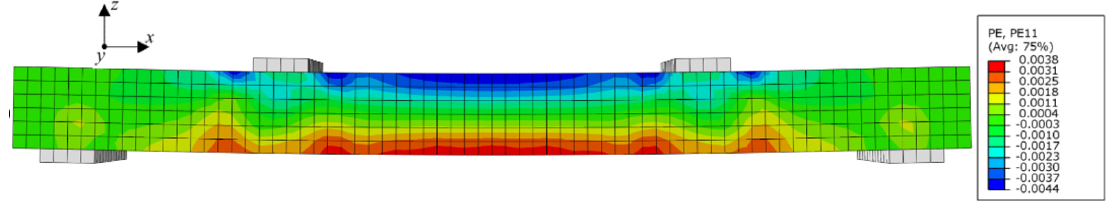
Figure 16. Flexural behavior of the numerical model S-A77-1 [17].